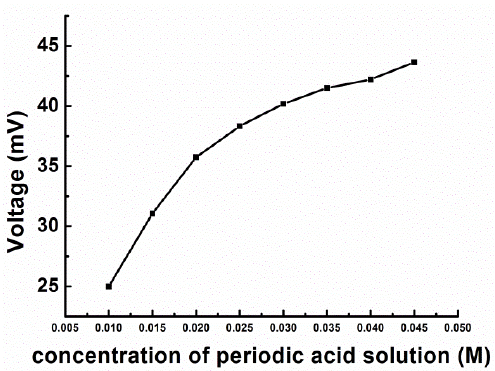
Figure 3. Effect of concentration of the periodic acid solution (pH 7) on the response of the FIA biosensor. A 350 μL sample of a 93.75 mg/L glucose solution was tested at a flow rate of 1.0